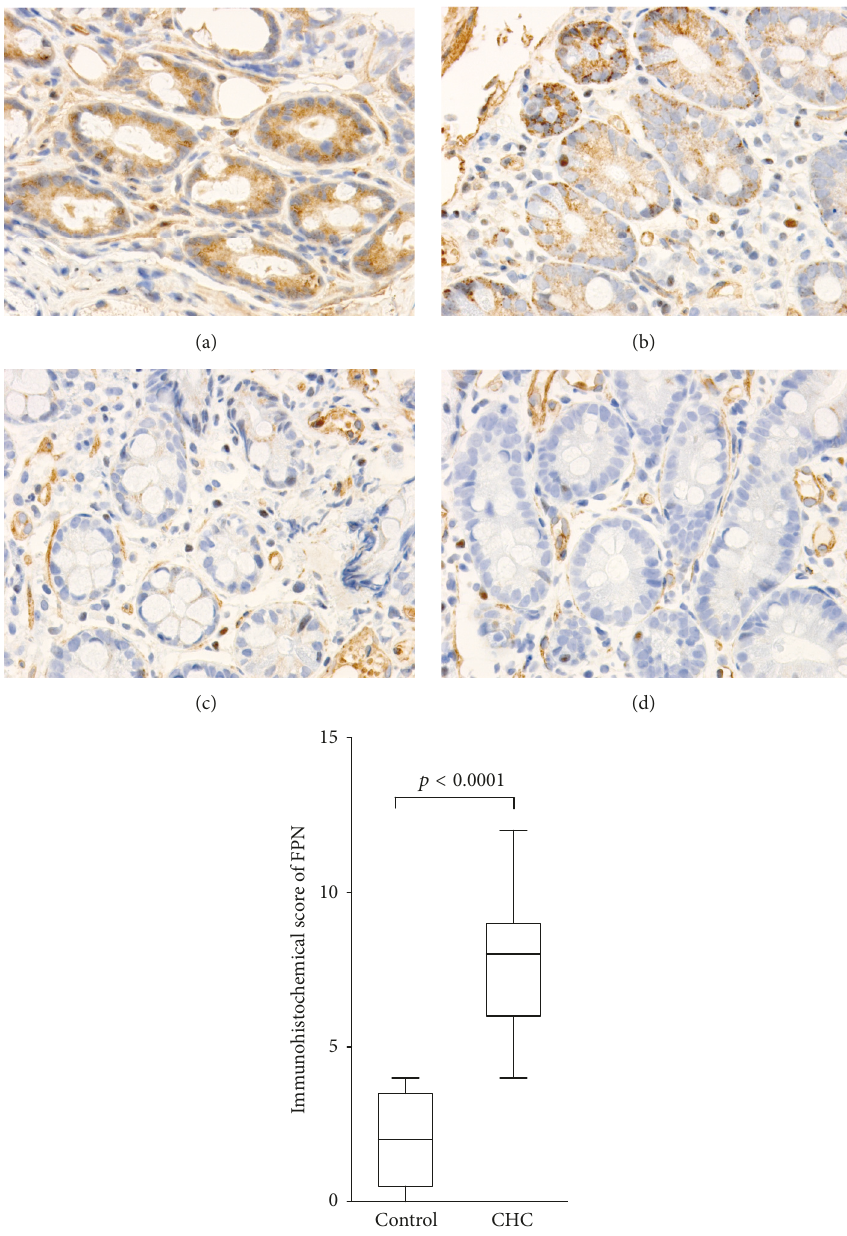
Figure 4: Immunohistochemicalanalysis of FPNin duodenum biopsy tissues from patients with CHC (a, b) and those of control participants (c, d). FPN expression was higher in the CHC group than in the control group. The immunohistochemical score was significantly higher in CHC patients compared with control participants